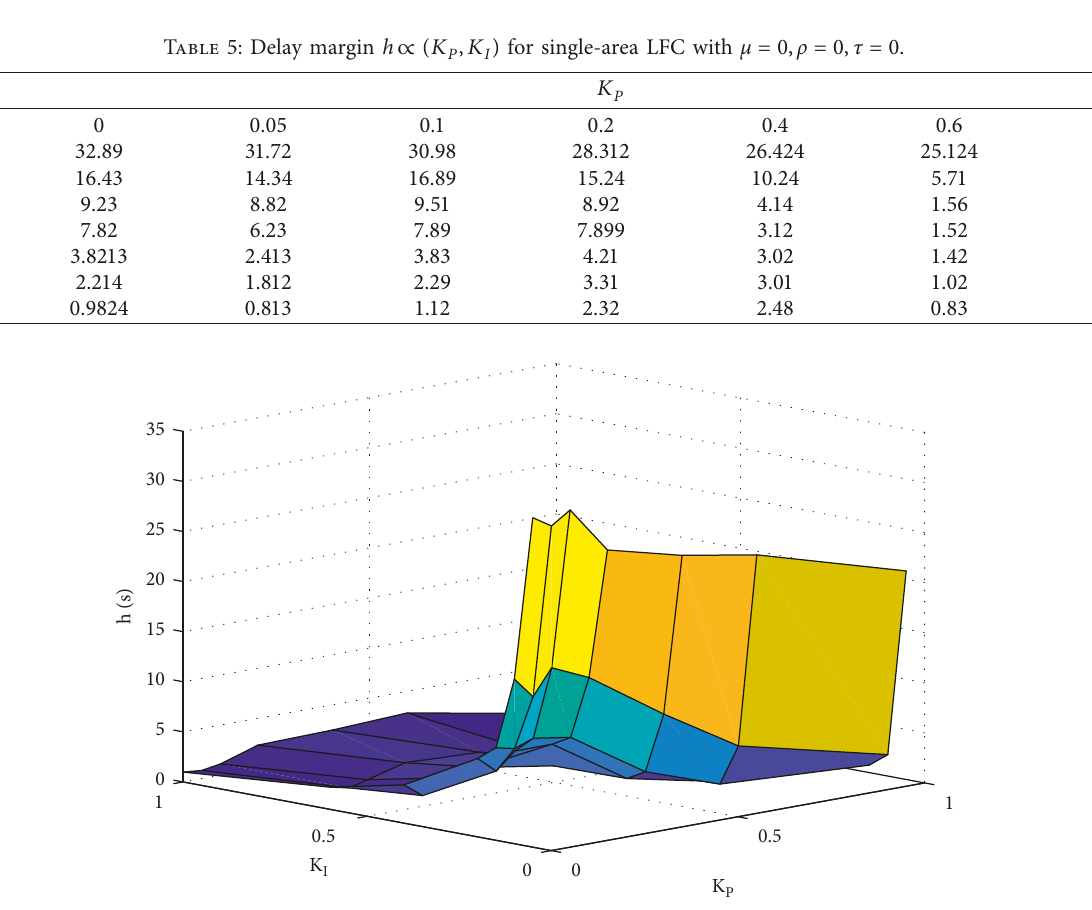
,K ) (single-area with μ � 0 , ρ � 0 , τ � P I